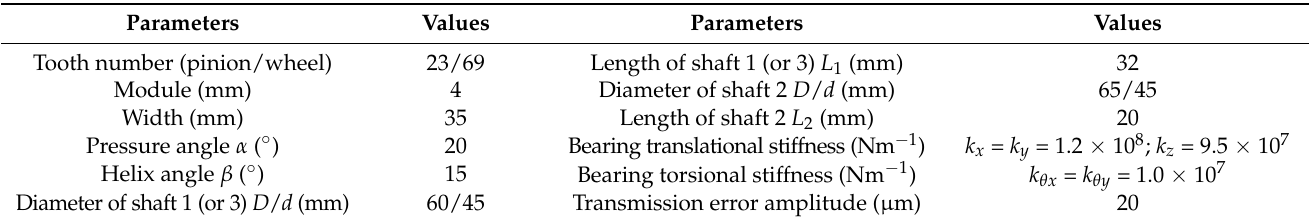
Table 2. Key parameters of